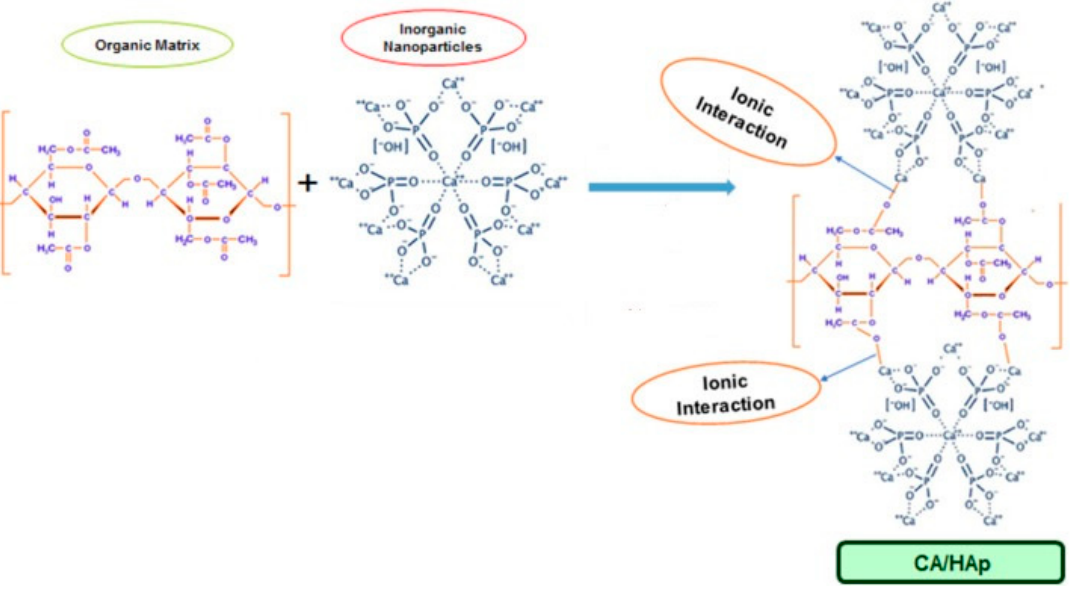
Figure 1. Proposed formation mechanism of cellulose acetate/hydroxyapatite hybrid composites (reproduced with permission from Ref. [60]).